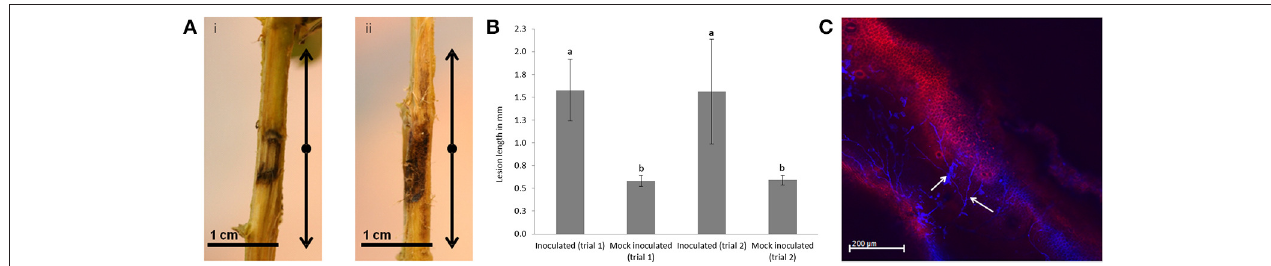
FIGURE 1 | Symptom development in Eucalyptus nitens following challenge with Phytophthora cinnamomi . (A) A section of 1.5cm stem tissue was harvested below and above the site of inoculation at 5 dpi. (i) Mock-inoculated and (ii) inoculated. (B) Lesions on E. nitens seedlings 6 wpi with P. cinnamomi . The small letters indicate that lesions on inoculated seedlings were significantly larger than the mock-inoculated negative control at p < 0.05 using the Mann–Whitney test for non-parametric data. Error bars show standard error based on n = 12 replicates. (C) Confocal microscopy of a longitudinal stem section showing P. cinnamomi hyphae (white arrows) at 4